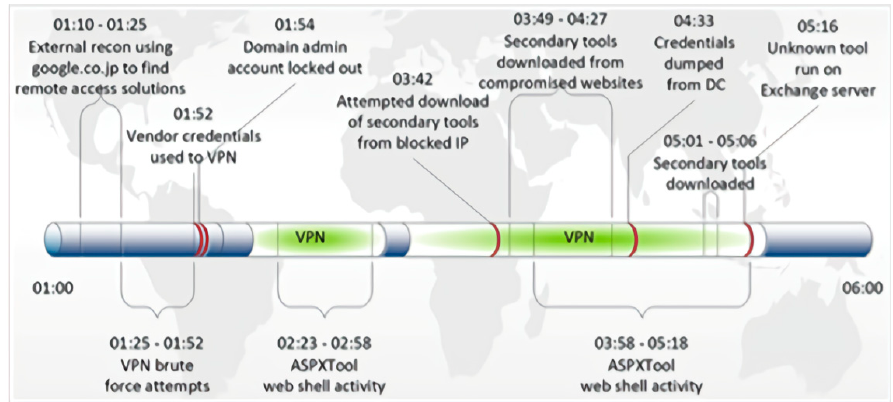
Figure 6. Timeline, in eastern-time, of TG-3390’s reentry into a compromised network.